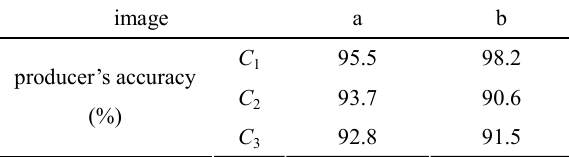
Figure 4. Templates of real SAR images: (a) coastal image template, and (b) city image template. Table 1. Quantitative evaluation